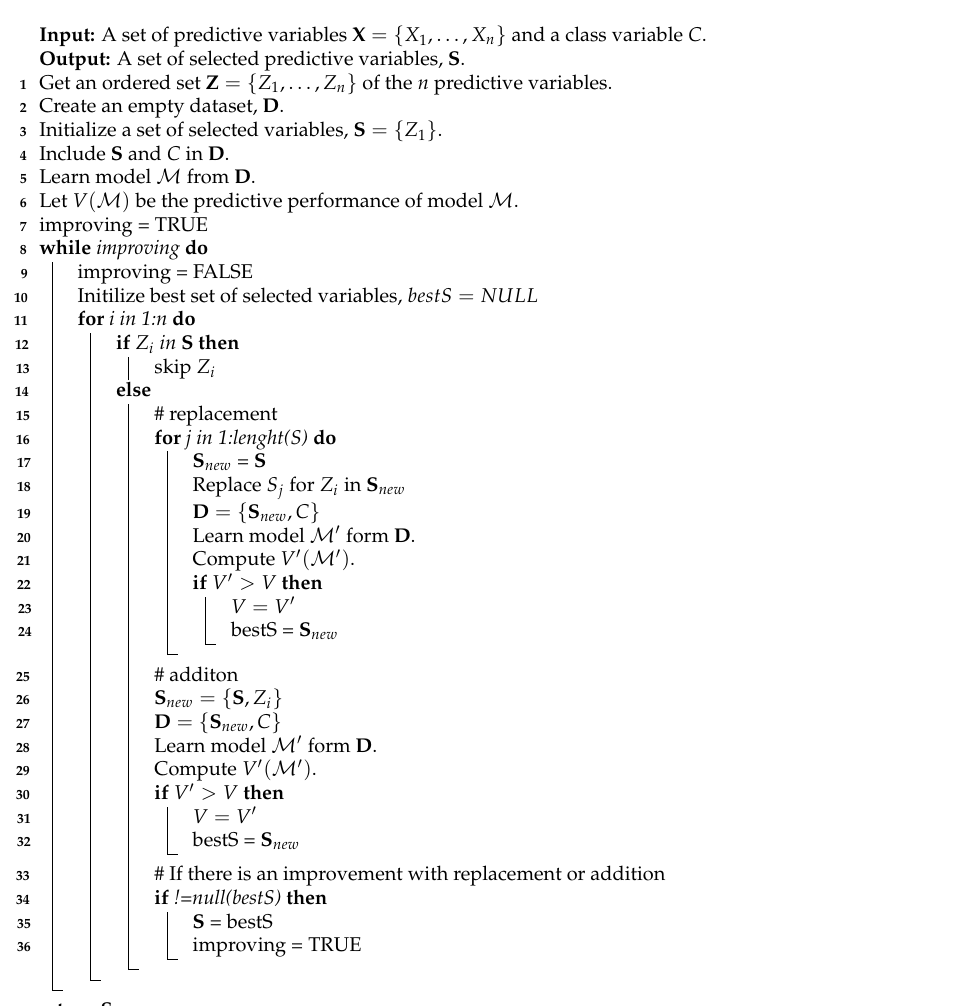
Algorithm 1: Incremental Wrapper Sequential Subset with Replacement